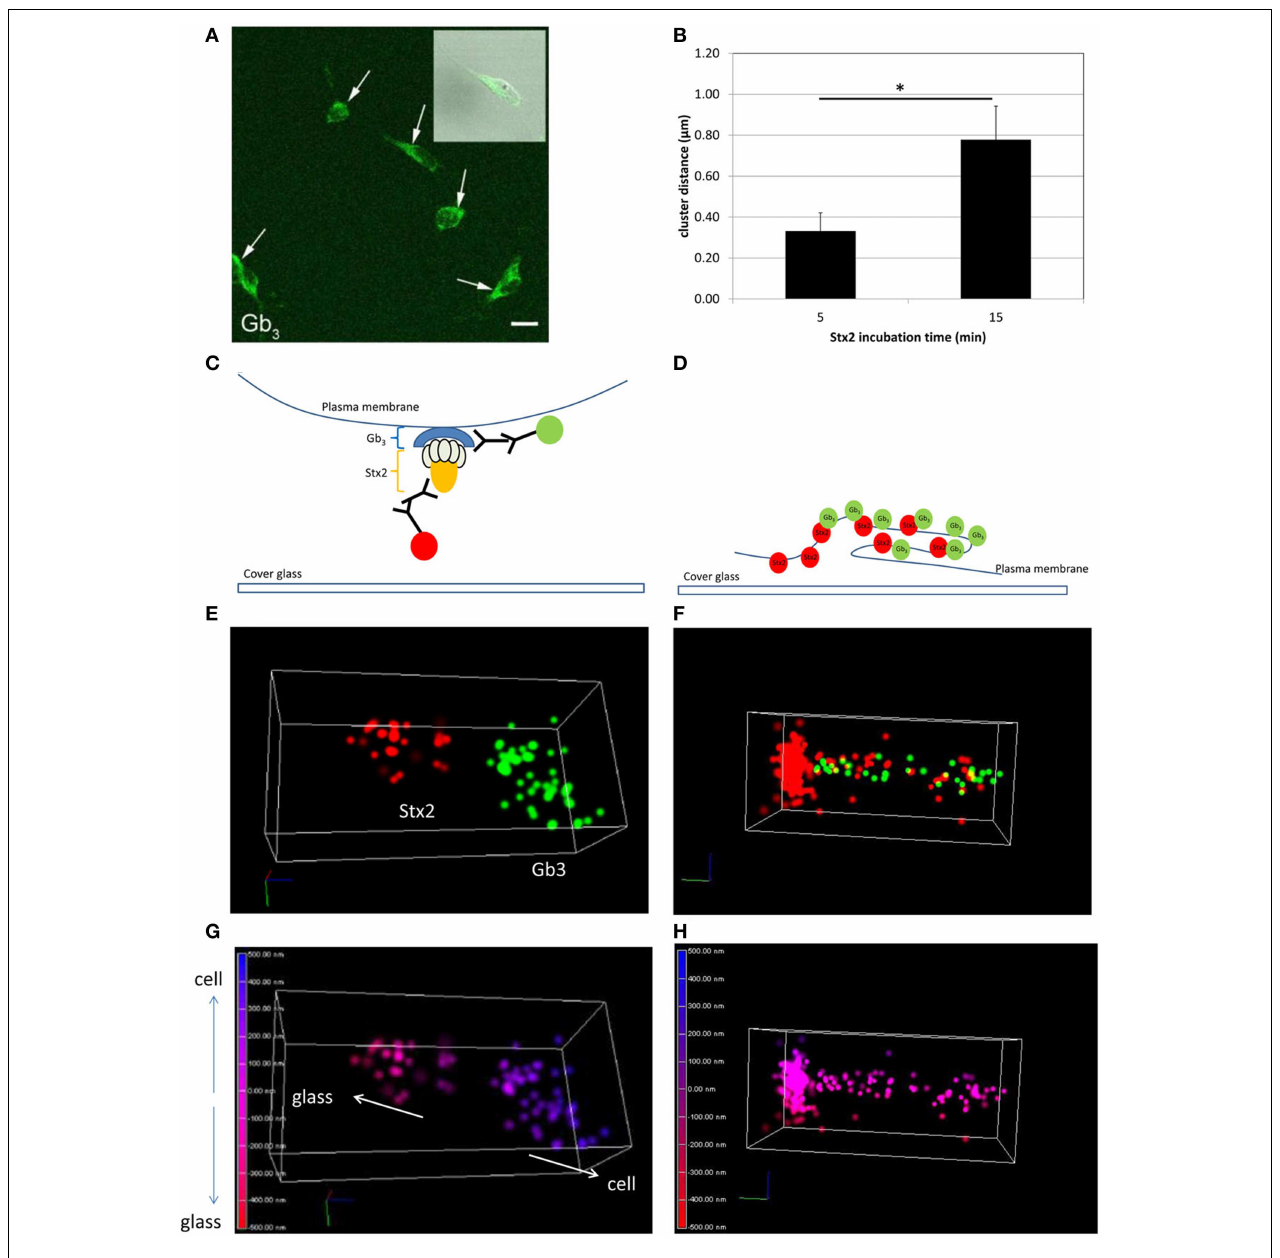
conjugated to AlexaFluor 488 (green)] and Stx2 [primary Ab against Stx2 and anti-mouse Ab conjugated to AlexaFluor 647 (red)] shown in cartoon format. (E,F) The STORM-TIRF images of contact spots from 5min (E) and 15min (F) incubations (Gb 3 in green and Stx2 in red). (G,H) The depth conversions of (E,F). The depth of the contact is color-coded from intracellular signal localization in blue (maximum depth of 500nm) to extracellular localization in red (minimum depth of -500nm) in continuous gradations where 0nm (purple) indicates the focused plane (plasma membrane). An upward arrow in (G) shows intracellular direction (cell) and a downward arrow shows extracellular direction (glass).